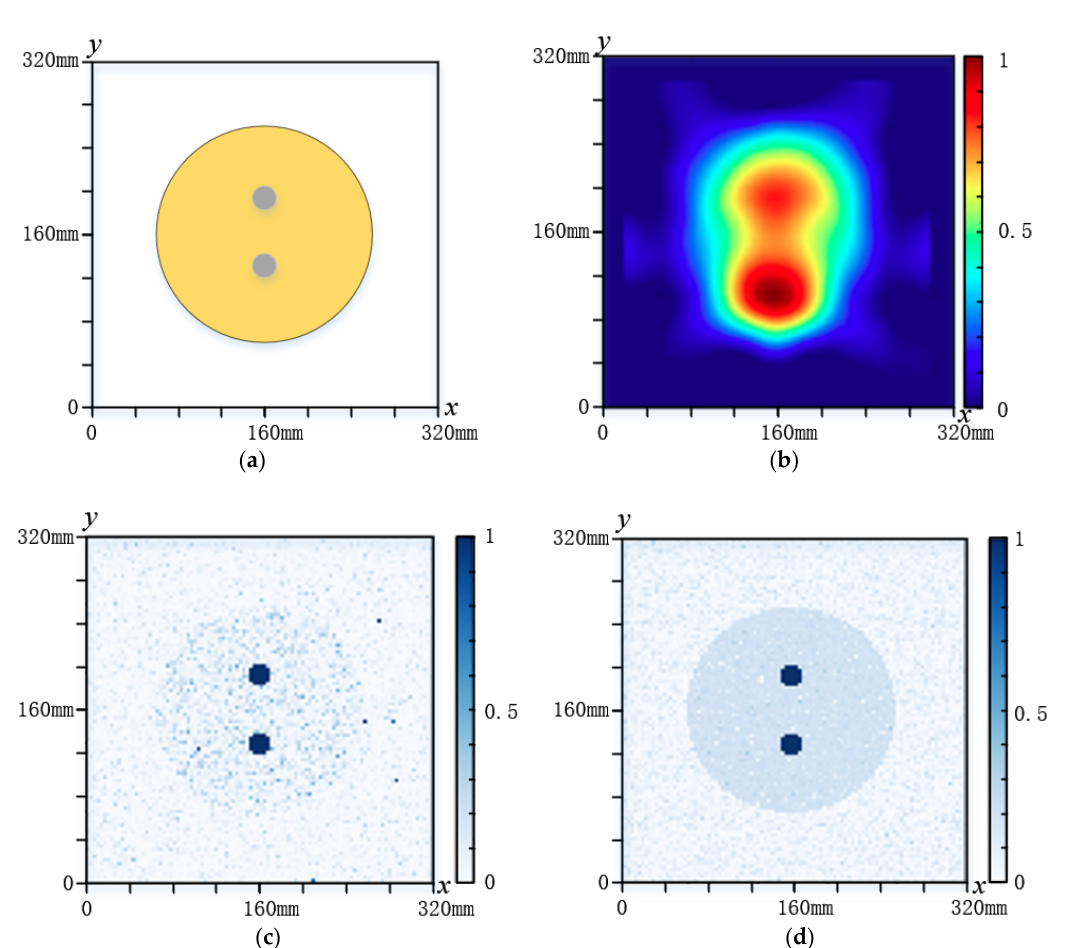
Figure 5. Homogeneous coaxial double defect model inversion imaging. ( a ) Homogeneous double defect model with a radius of 2 cm. ( b ) CSI inversion results. ( c ) BP neural network inversion results. ( d ) Model-driven deep learning network inversion results .